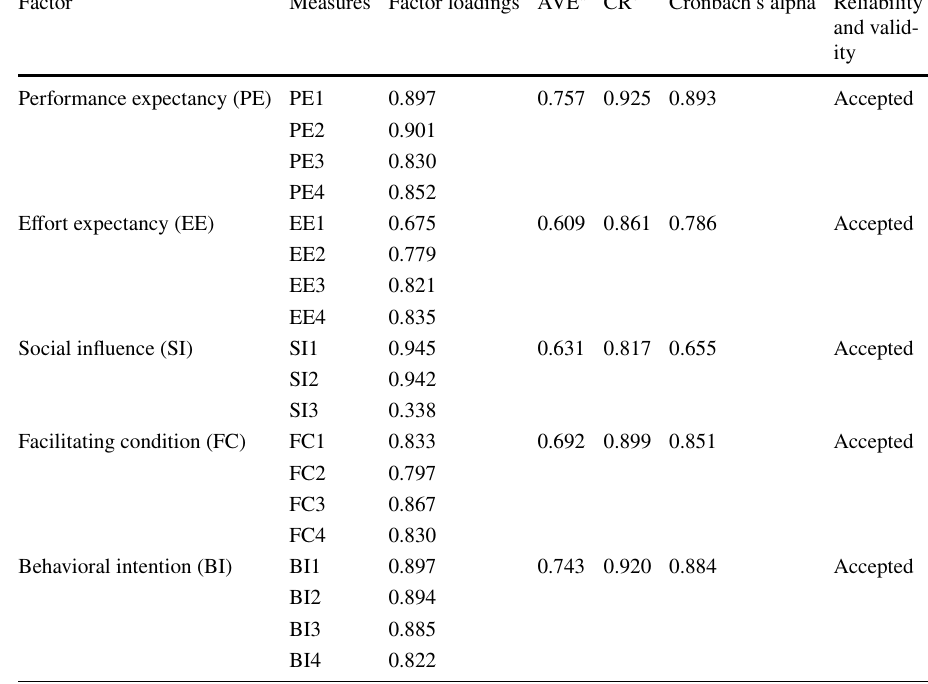
Table 3 Factor loadings, reliability and validity